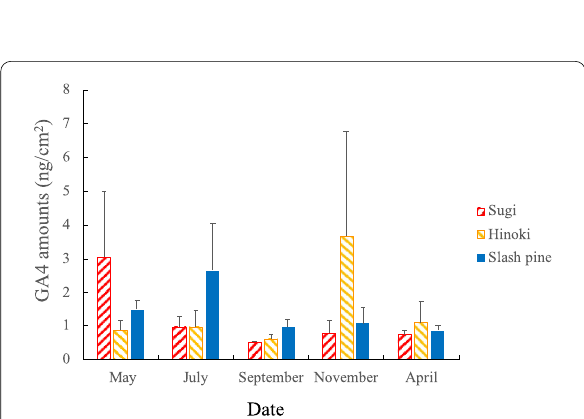
Fig. 3 Seasonal variation of IAA levels in three conifers. A Sugi and hinoki; B slash pine. Data are means